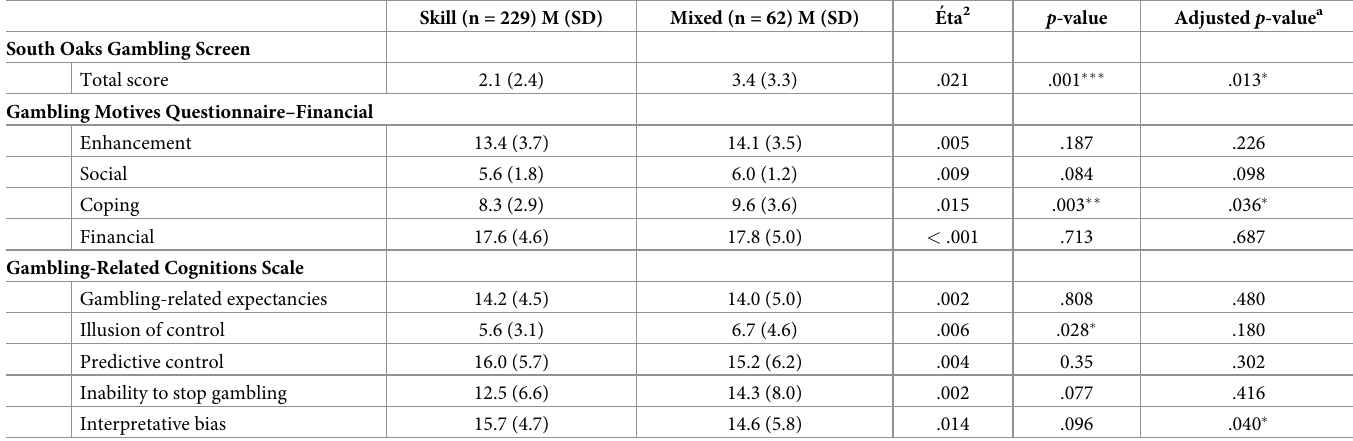
Table 3. South Oaks Gambling Screen, Gambling Motives Questionnaire–Financial, and Gambling-Related Cognitions Scale scores as a function of gambling